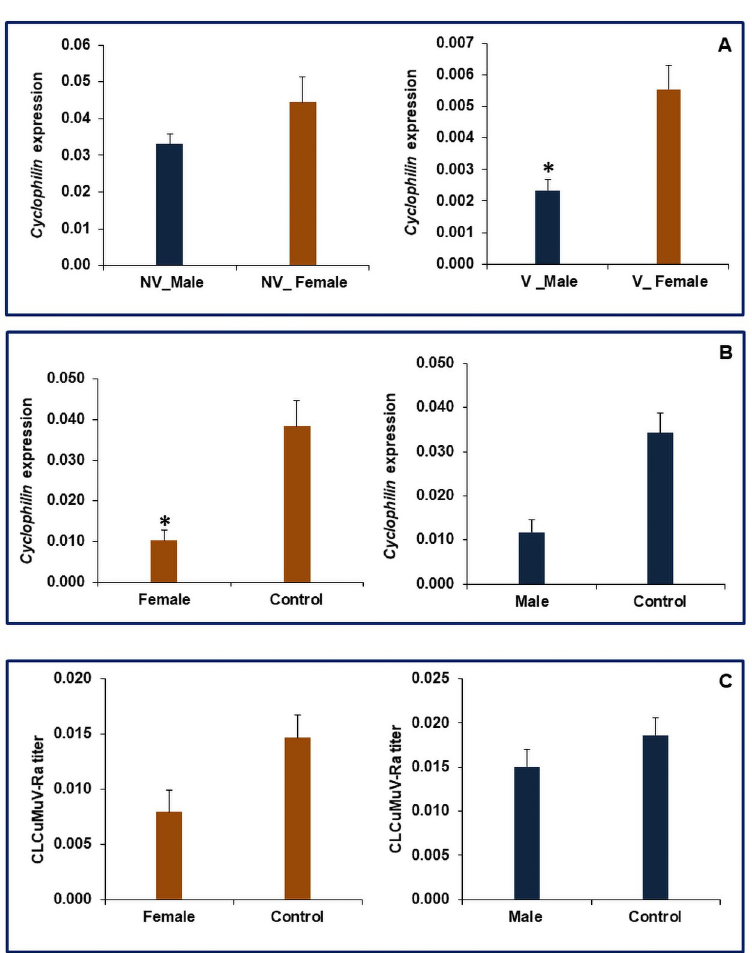
Fig 5. Relative expression of Cyclophilin in B . tabaci , A. Non-viruliferous and Viruliferous whiteflies, B. dsRNA fed female and male whiteflies; C. Relative titer of Cotton leaf curl Multan virus -Rajasthanin Cyclophilin knockdown viruliferous female and male whiteflies. The expression level was normalized with β -tubulin as housekeeping gene. Error bars represent the standard deviation (n = 3) and � represents significant differences in expression (P � 0.05, Student’s